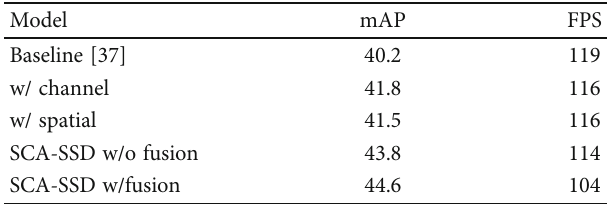
Table 4: Ablation experiment results on the Oxford hand dataset.